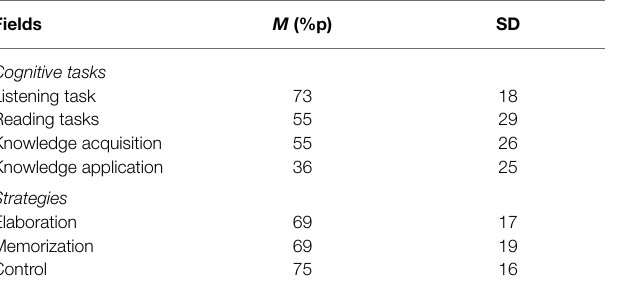
TABLE 3 | Means for strategy fields. Fields Cognitive tasks Listening task